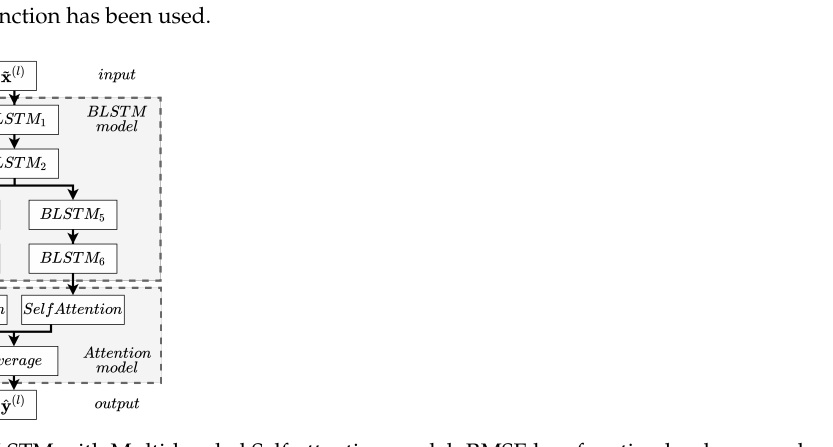
Figure A3. BLSTM with Multi-headed Self-attention model. RMSE loss function has been